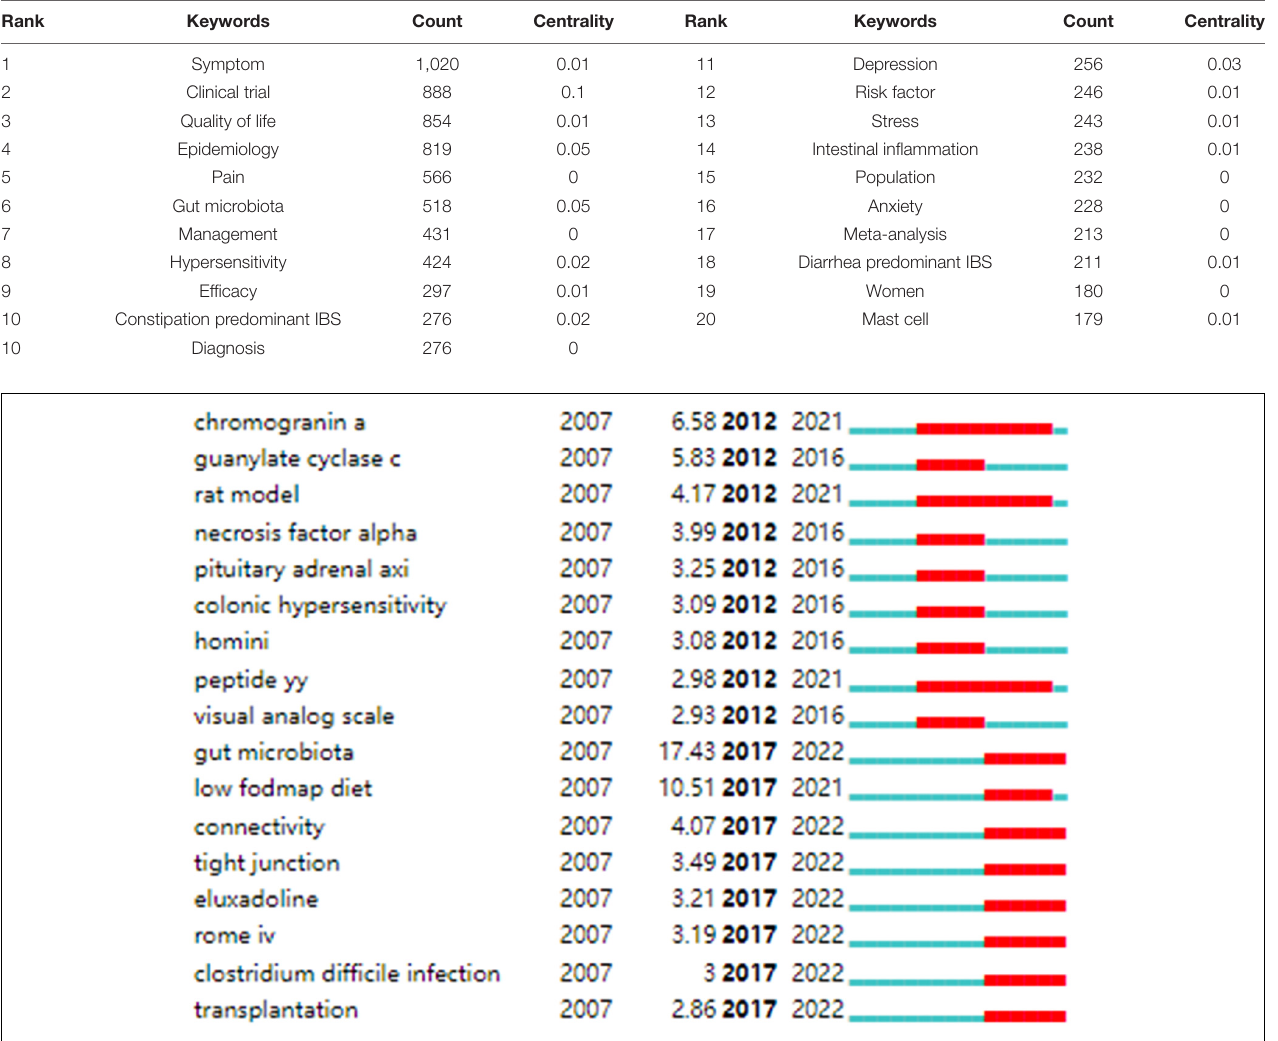
FIGURE 9 | Keywords with strong citation bursts in IBS